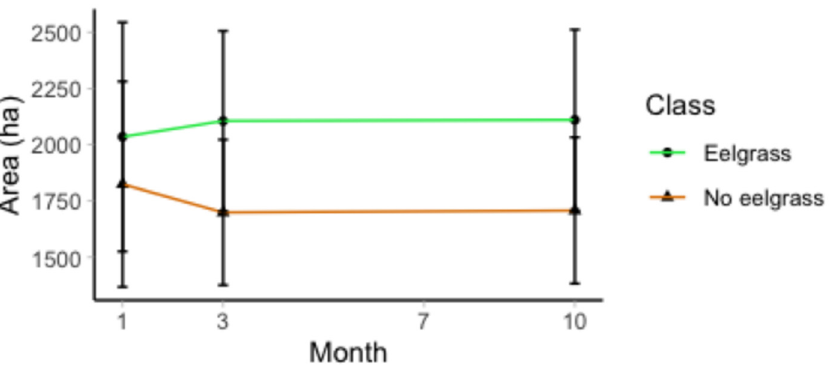
Figure 4. Area (ha) of the bay with Eelgrass and No Eelgrass cover, as predicted from SVM classifications of satellite imagery. Error bars incorporate satellite and UAV classification error.